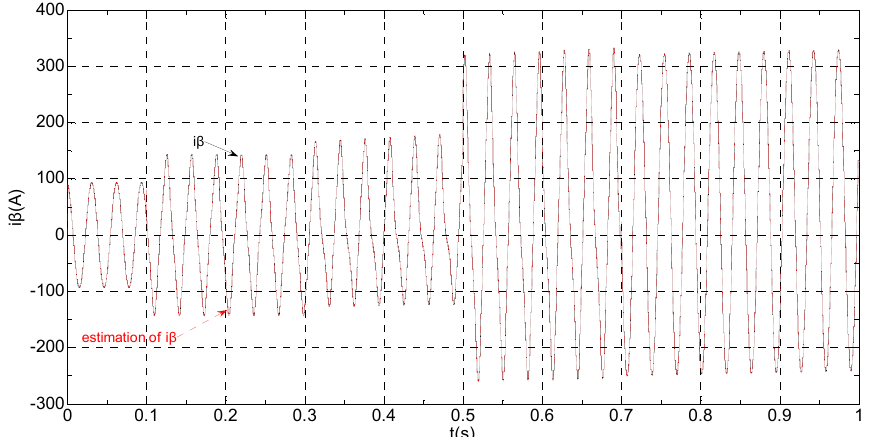
Figure 11. The actual and estimated values of i β .